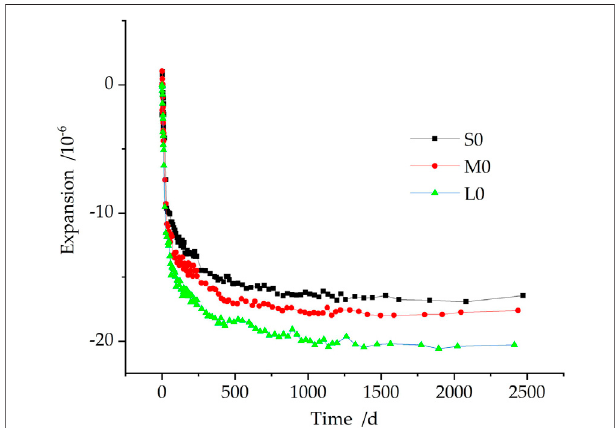
FIGURE 4 | Autogenous volume deformation of long-aged concrete mixed with 8% MgO at different specimen sizes.